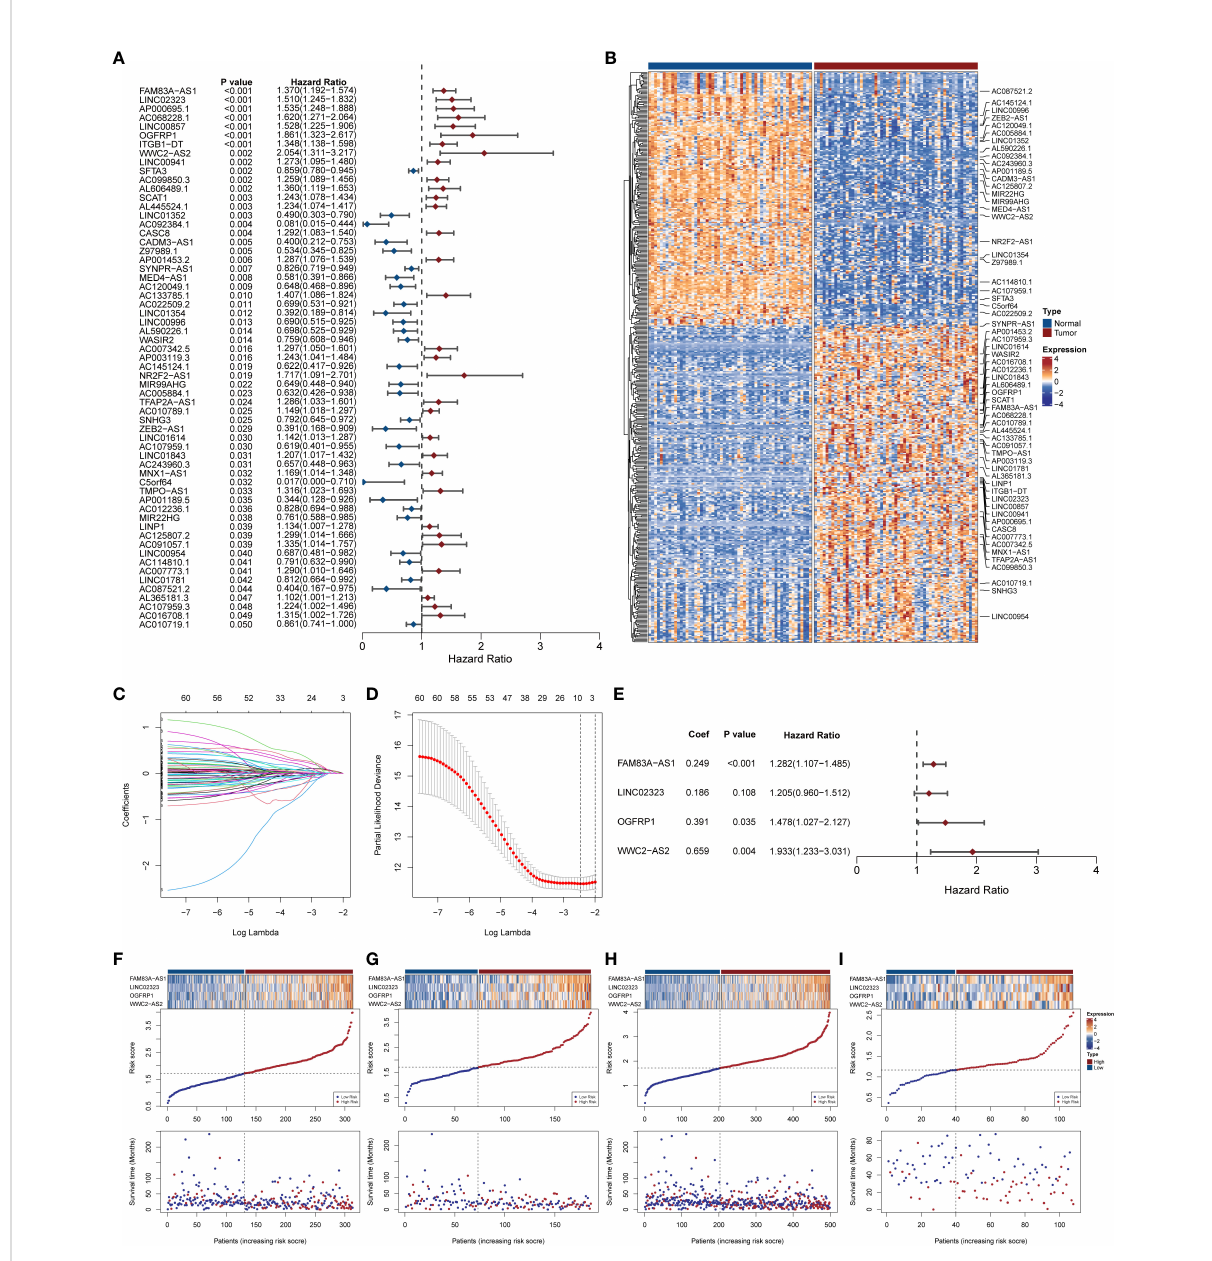
FIGURE 2 Extraction of necroptosis-related lncRNA signature and construction of Necroptosis-related LncRNA Risk Scoring (NecroLRS) model. (A) Prognostic lncRNAs extracted by univariate COX regression. The corresponding p-values and hazard ratios are listed following each lncRNA. The forest plot reveals the value and con fi dence interval of each lncRNA. The red color demonstrates corresponding lncRNA as a hazardous factor, while blue color indicates a protective factor. (B) Expression pro fi le of prognostic lncRNAs extracted via univariate COX regression in matrices with paired TCGA-LUAD expression. Variable selection based on LASSO regression (C) and cross-validated errors of various levels of regularization (D) were visualized. (E) Necroptosis-related LncRNA Risk Scoring (NecroLRS) model information. (F – I) Exhibition of NecroLRS and corresponding patients ’ survival status in training, test, whole, and validation